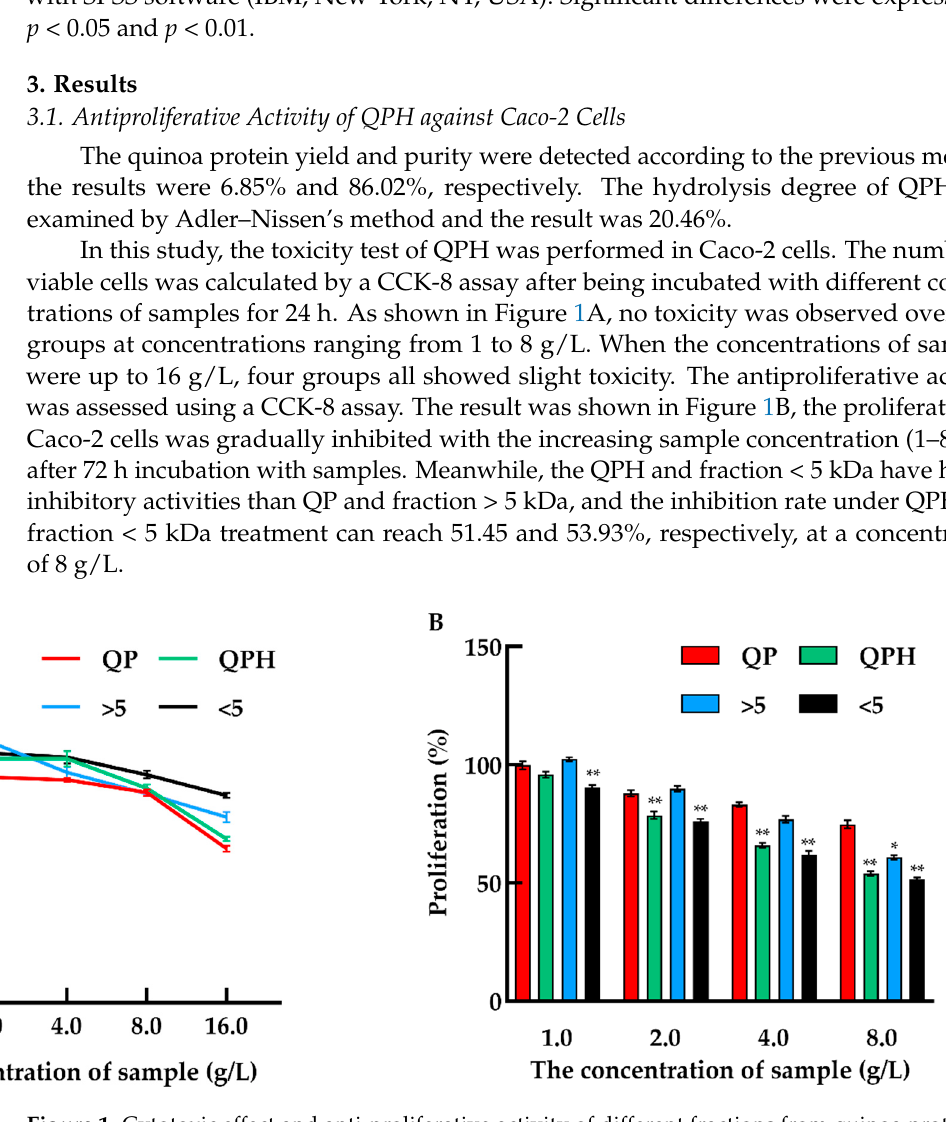
Figure 1. Cytotoxic effect and anti-proliferative activity of different fractions from quinoa protein on Caco-2 cells. ( A ) Dose dependent effect of different quinoa protein fractions on Caco-2 cells after 24 h treatment; ( B ) the cell proliferation rate of Caco-2 cells under gradient concentration of quinoa protein fractions after 72 h treatment. QP: quinoa protein concentrate, QPH: quinoa protein hydrolysate, >5 kDa: fractions MW > 5 kDa, <5 kDa: fractions MW < 5 kDa. * p < 0.05 and ** p < 0.01 indicate significant and highly significant differences between the QP and other treatments, respectively.